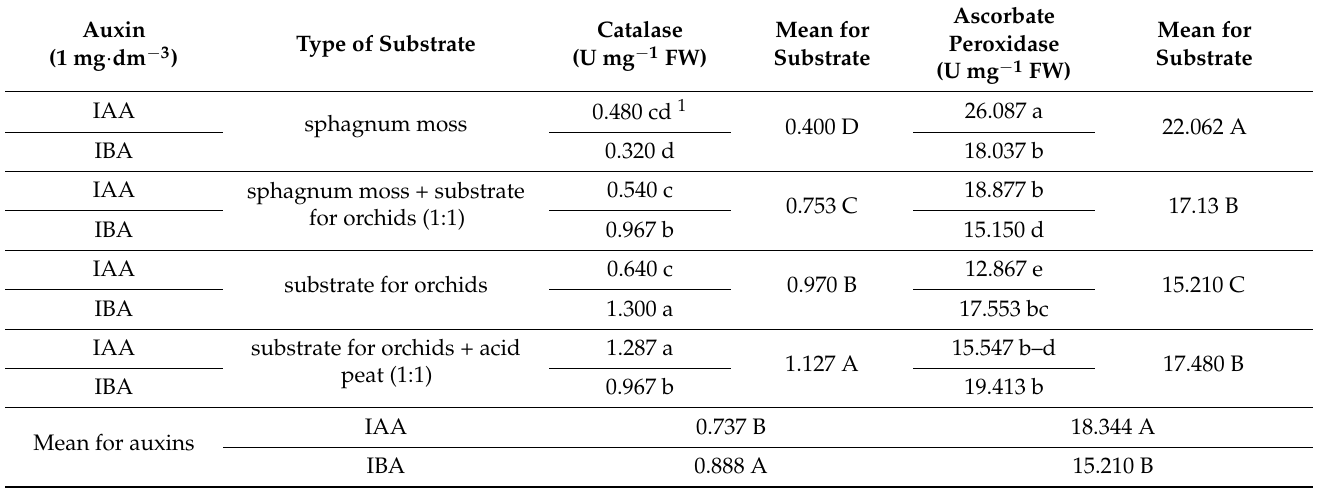
Table 8. A subsequent effect of IAA or IBA and substrate type on the catalase and ascorbate peroxidase content in P. insigne leaves during